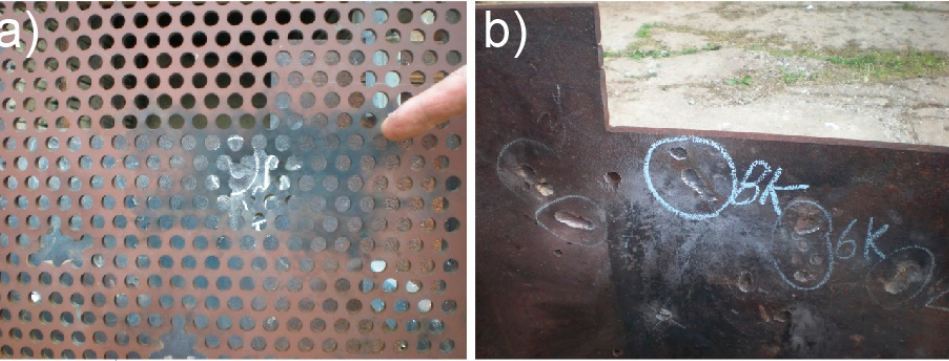
Figure 5. Perforated plate damage ( a ); base plate with two dents on the base plate ( b ) [15]. The average number of interconnected perforations in steel specimens drops as the perforations become larger for the same material (H9-6-0, H10-6-0, H11-6-0). However, a quite opposite trend can be observed in terms of the damaged areas. The main reason is